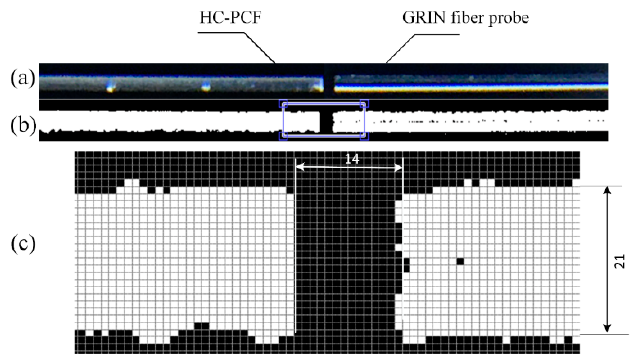
Figure 5. Initial distance measurement between the GRIN fiber probe and HC-PCF: ( a ) original image, ( b ) binarization processing, and ( c ) image in pixels. ( b ) binarization processing, and ( c ) image in pixels.